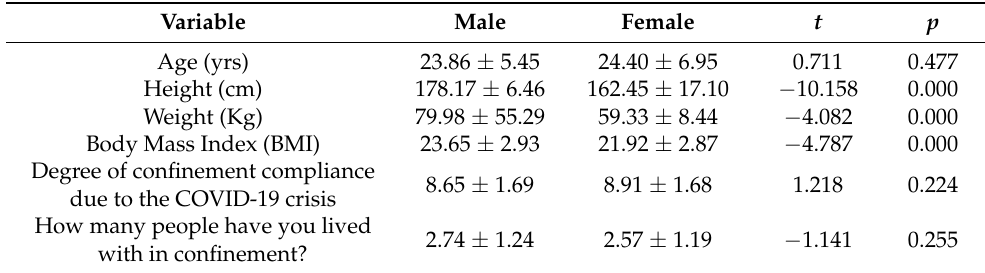
Table 1. Gender differences in sociodemographic factors.